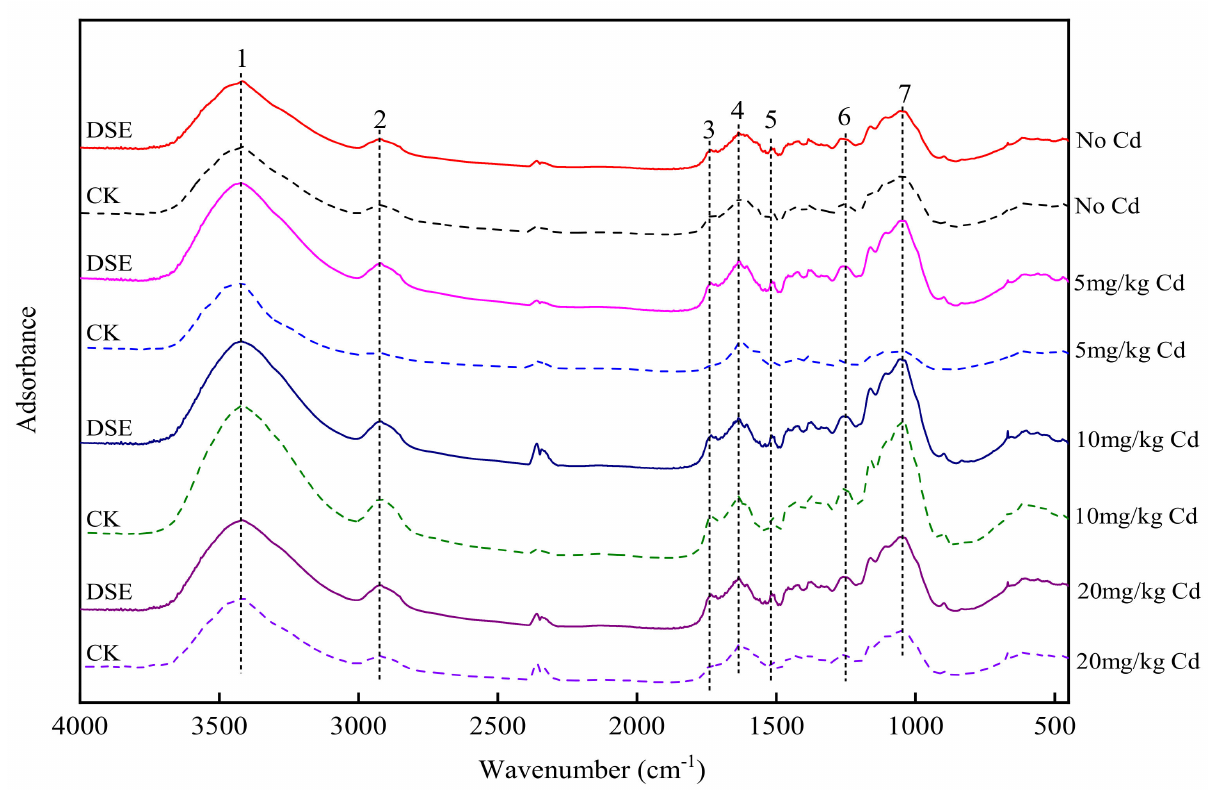
Figure 5. Changes in FTIR spectra of RCWs before and after Cd stress and DSE inoculation. Cd: cadmium treatment; CK: the control of non-inoculation; DSE: Exophiala pisciphila